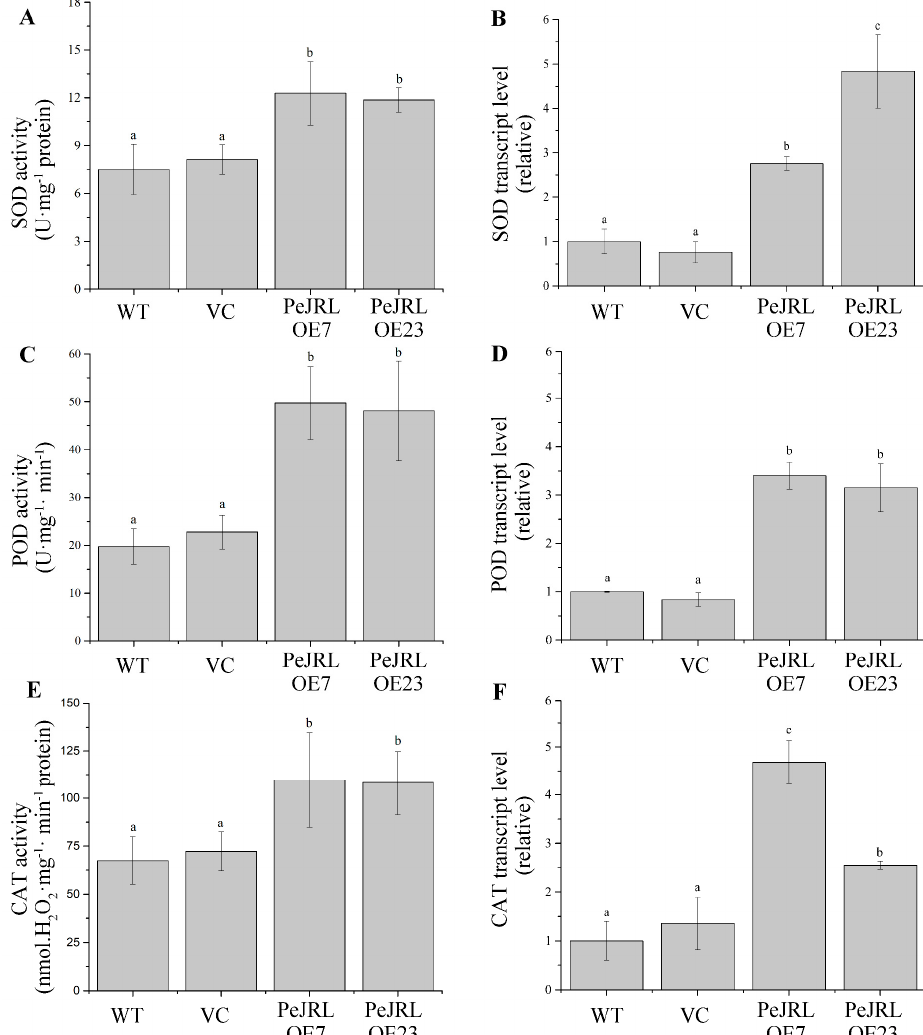
Figure 8. Effect of NaCl (75 mM, 10 d) on total activities of superoxide dismutase (SOD), catalase (CAT), peroxidase (POD), and transcription levels of encoding genes in wild-type (WT) Arabidopsis, vector control (VC), and PeJRL -transgenic lines (OE7 and OE23). ( A , C , E ) Total activities. ( B , D , F ) Transcription levels. Transcription of AtSOD , AtPOD , and AtCAT was detected with RT-qPCR. The Arabidopsis AtACTIN2 was used as the internal control. Primers designed to target AtSOD , AtPOD , AtCAT , and AtACTIN2 genes are shown in Supplementary Materials Table S1. Each column corresponds to the mean of three replicated experiments, and bars represent the standard error of the mean. Columns labelled with different letters (a–c) denote significant difference at p < 0.05.